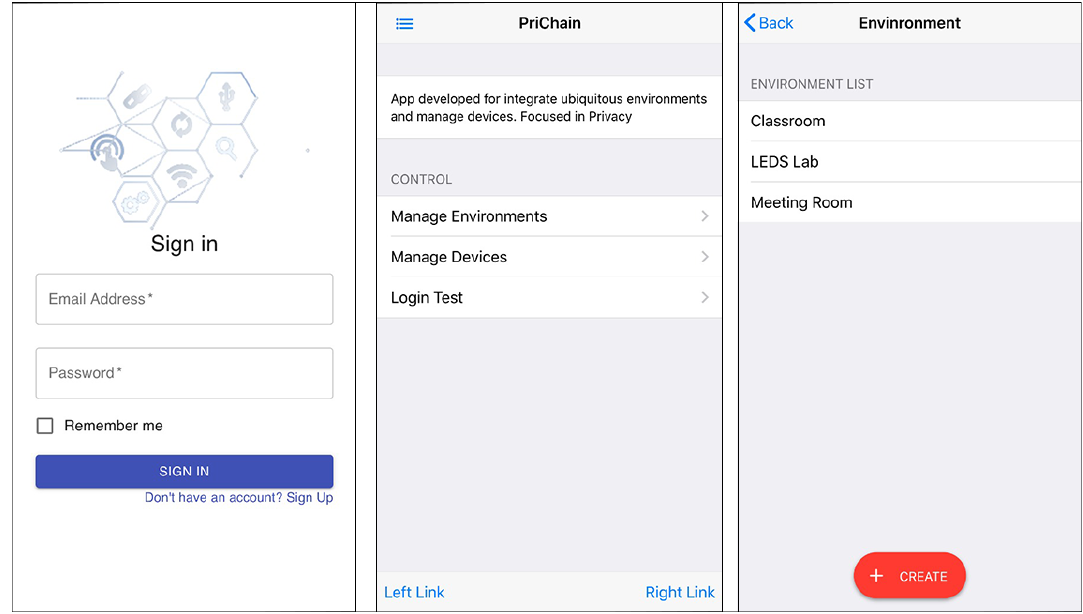
Figure 8. PriChain